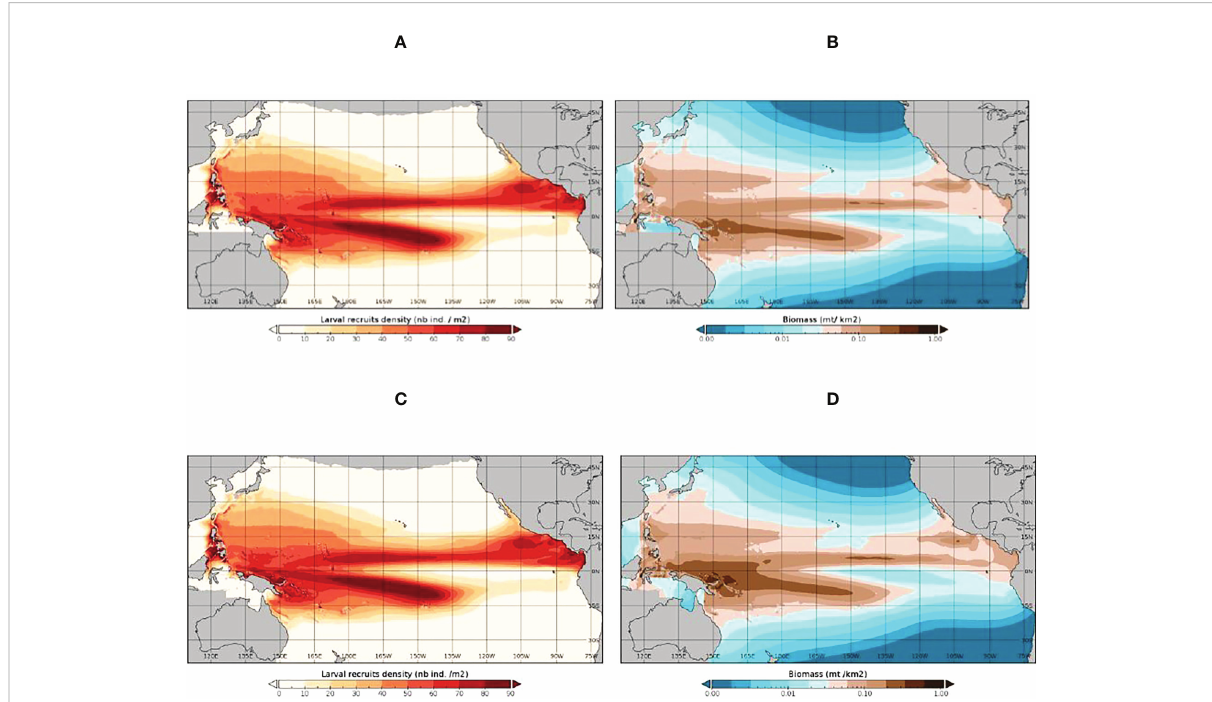
FIGURE 4 The SEAPODYM-simulated 1998-2019 average distribution of skipjack tuna larvae (A, C) and spawning biomass (B, D) under the observed (Fref) level of fi shing (A, B) and under unexploited (F0) conditions (C, D) .